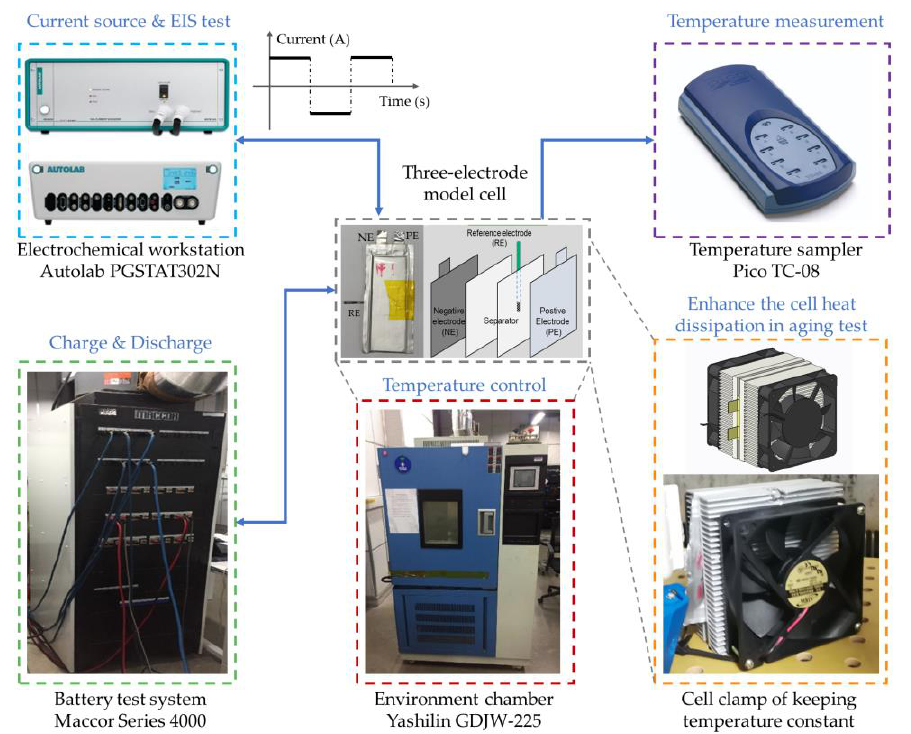
Figure 2. The experimental platform for EIS and preheating tests.